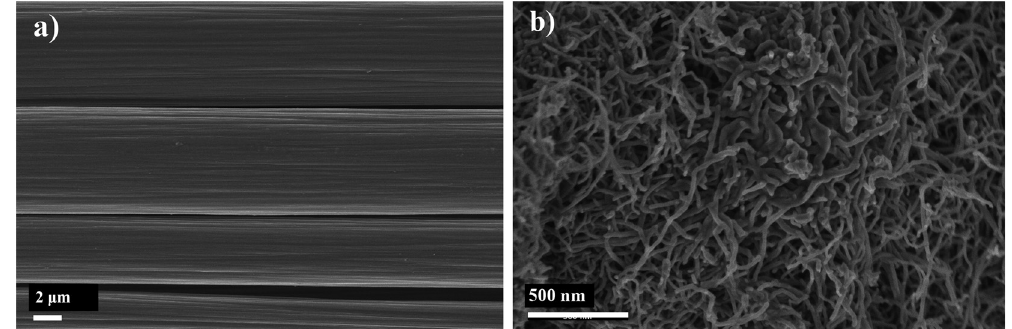
Figure 2: SEM images of ( a ) CF and ( b ) CNT.